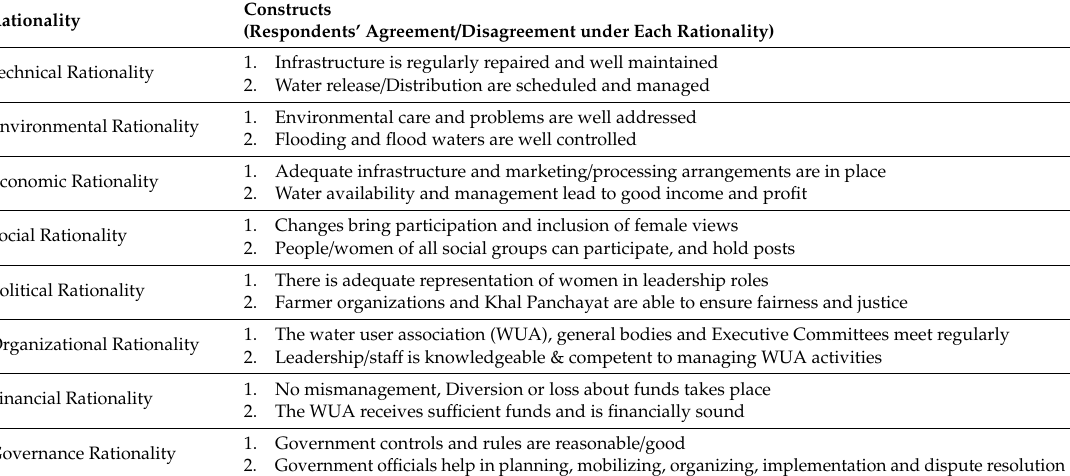
Table 2. Di ff erent rationalities and their questions.